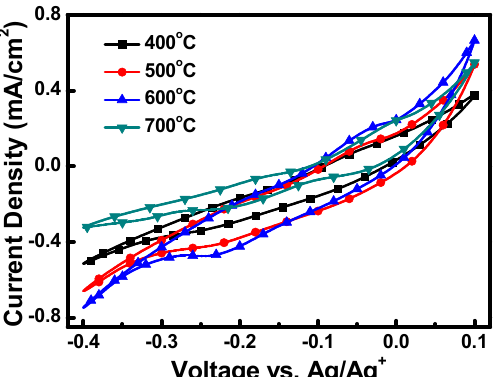
Figure 6. X-ray photoelectron spectroscopy (XPS) analytic results of the Cu 2 O counter electrodes sintered at various temperatures.